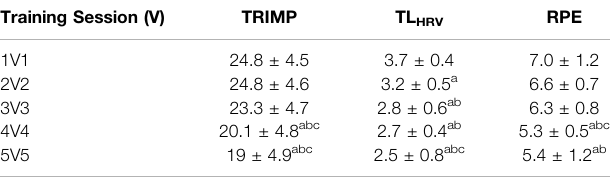
TABLE 2 | Internal load assessment of fi ve ball-drills. Training Session (V)